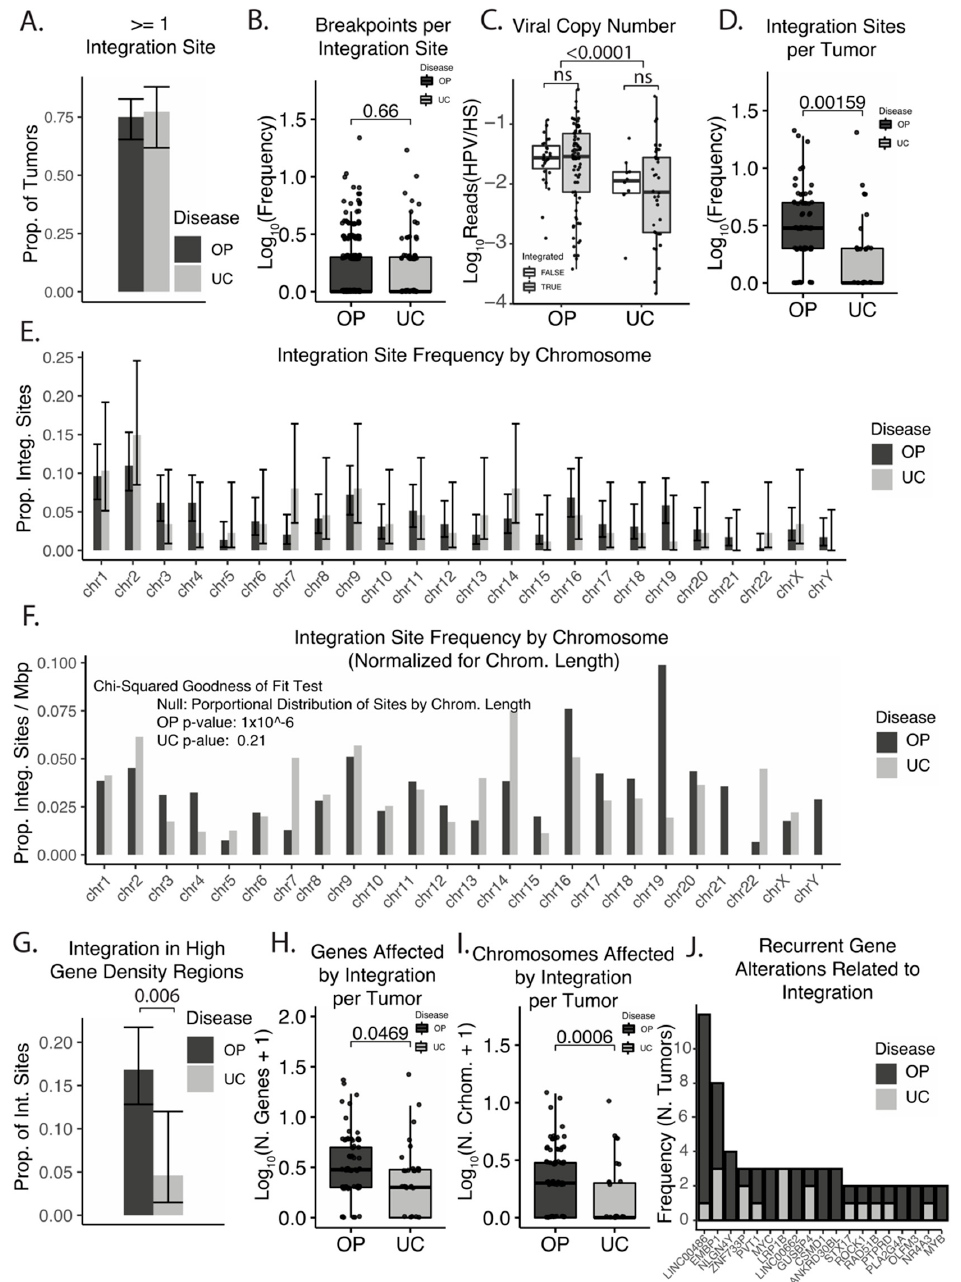
Figure 1. Features of HPV16 genomic integration and integration sites in OPSCC and UCSCC. ( A ) Bar plot—proportion of tumors with detectable integration. Error bars represent 95% confidence intervals. ( B ) Box plot—number of human–viral breakpoints per integration site. Significance based on Wilcoxon Rank-sum test, p -values are indicated in plot. ( C ) Box plot—relative viral copy number by disease and integration status. Significance based on Wilcoxon Rank-sum test, p -values are indicated in plot. ns—not significant. ( D ) Box plot—number of integration sites per tumor. Significance based on Wilcoxon Rank-sum test, p -values are indicated in plot. ( E ) Bar plot—proportion of integration sites by chromosomal location. Error bars represent 95% confidence intervals. ( F ) Bar plot—proportion of integration sites by chromosomal location normalized by chromosome length. Significance based on chi-squared goodness of fit test, with sites’ distribution based on chromosome size as a null hypothesis. ( G ) Bar plot—proportion of integration sites in high gene density regions. High gene density was defined as top 5% of genomic space. Error bars represent 95% confidence